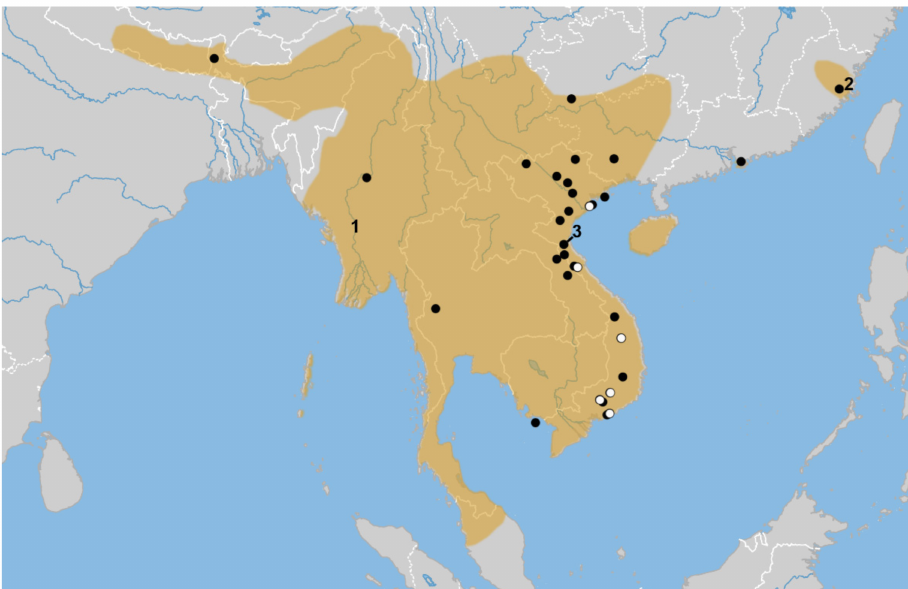
Figure 1. Distribution range of Hipposideros gentilis (adopted from [18]). Localities of morphologically studied material are marked with full circles; localities for original genetic samples ( cyt b and nuclear genes) are marked with empty circles. Type localities of named forms are numbered as follows: 1— gentilis Andersen, 2— sinensis Andersen, 3— megalotis